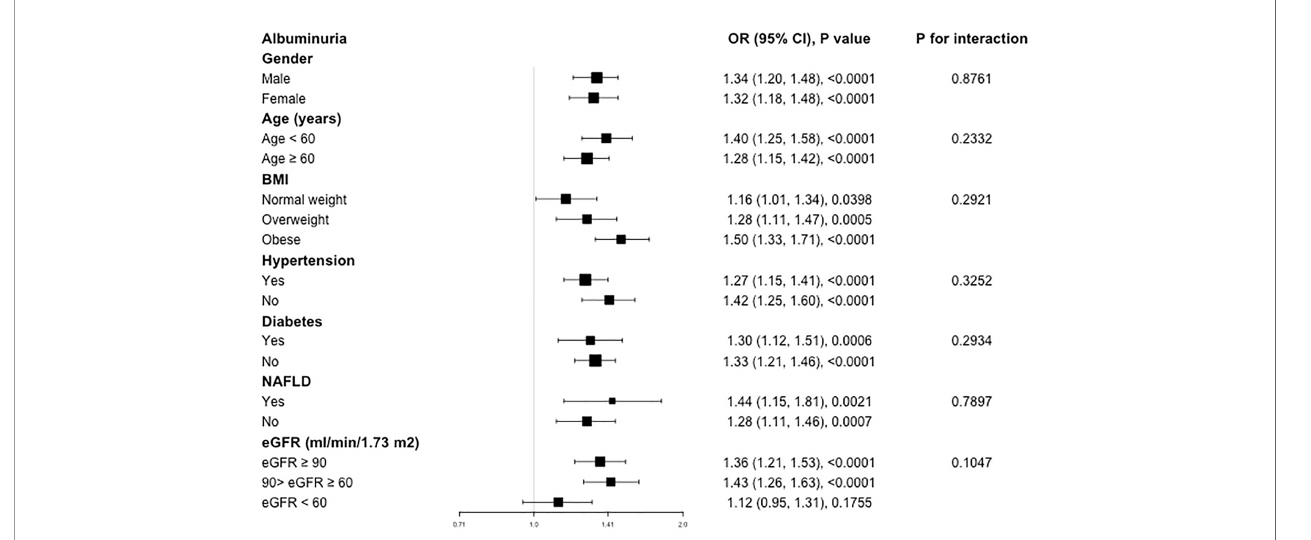
FIGURE 2 | Subgroup analysis for the association between SII and